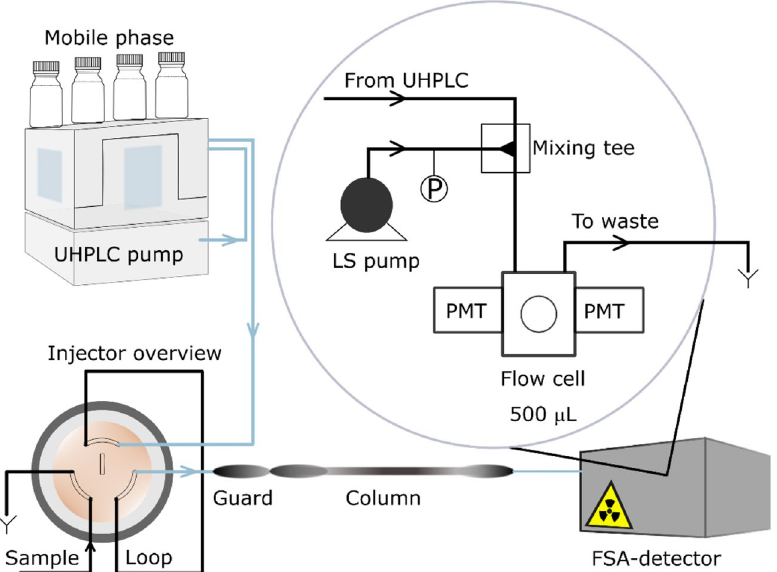
Figure 1. Schematic of the ultra-high-performance liquid chromatography-flow scintillation analysis (UHPLC- FSA) system with the internal configuration of the